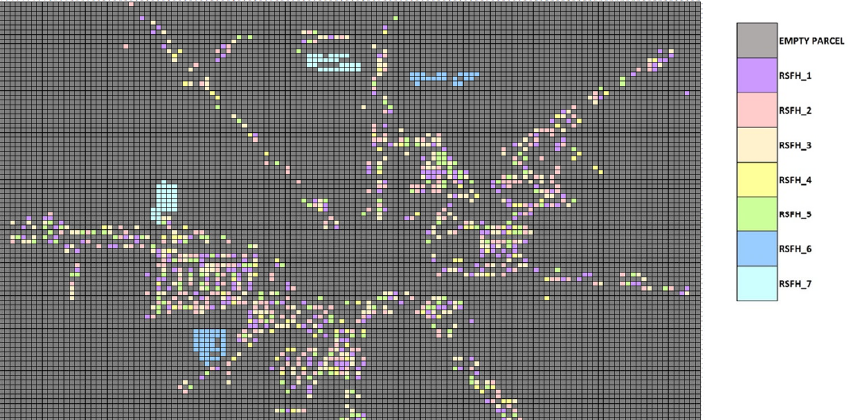
Figure 6. Schema of the Nowosolna cluster in the TEAC software.